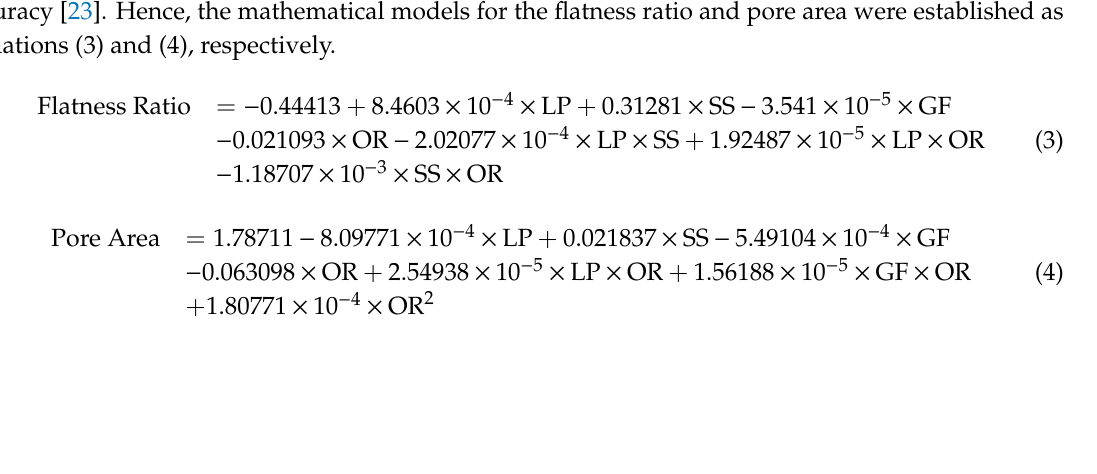
Table 3. Central composite design of input variables and the corresponding responses.